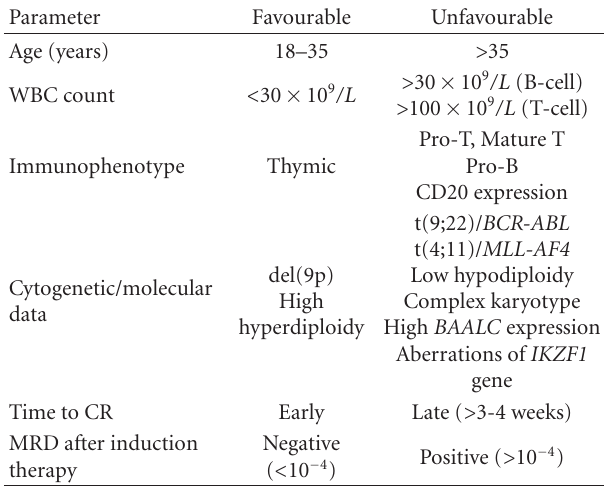
Table 3: Risk stratification in adult ALL (adapted from [36] and